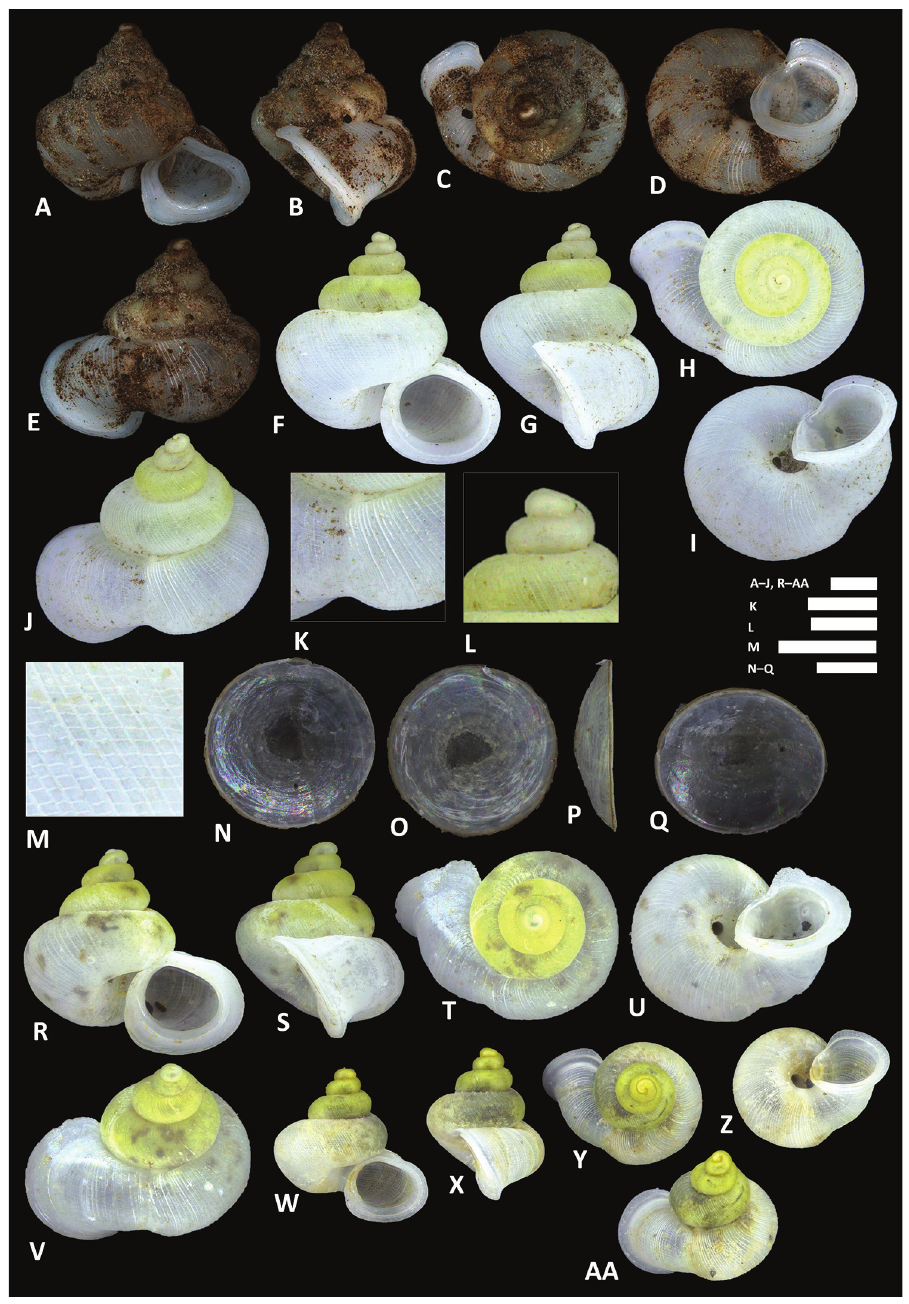
Figure 21. Alycaeus kelantanensis Sykes, 1902. A–E Shell of syntype, RMNH 153594 F–J Shell of BOR/MOL 8327 K–M Close up of shell of BOR/MOL 8327 N–Q Operculum of BOR/MOL 6825 R–V Shell of BOR/MOL 12973 W–AA Shell of BOR/MOL 12974. Scale bars: A–J, K, R–AA 1 mm; L, M, N–Q 0.5 mm. Photographs A–E by Thor Seng Liew. Photographs F–AA by Junn Kitt